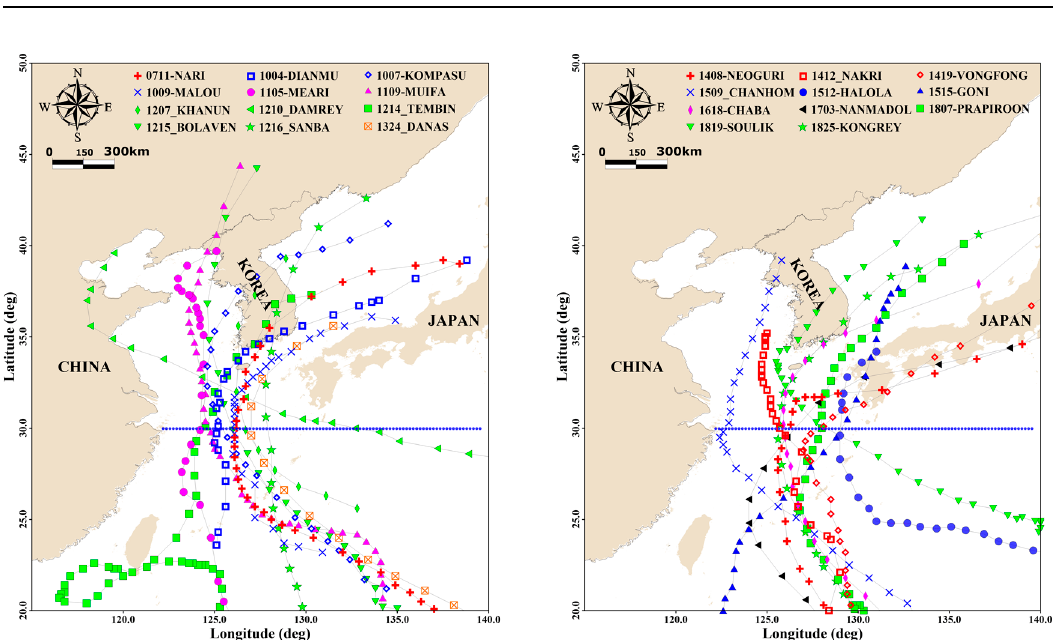
Figure 17. Paths of typhoons that affected the Korean Peninsula: (a) 2007–2013 and (b) 2014–2018. In running the models for hindcasting, the impact of these typhoons is evaluated by means of the wind fields. In calculating the wave parameters and energy, however, it is found that the contributions of storms are